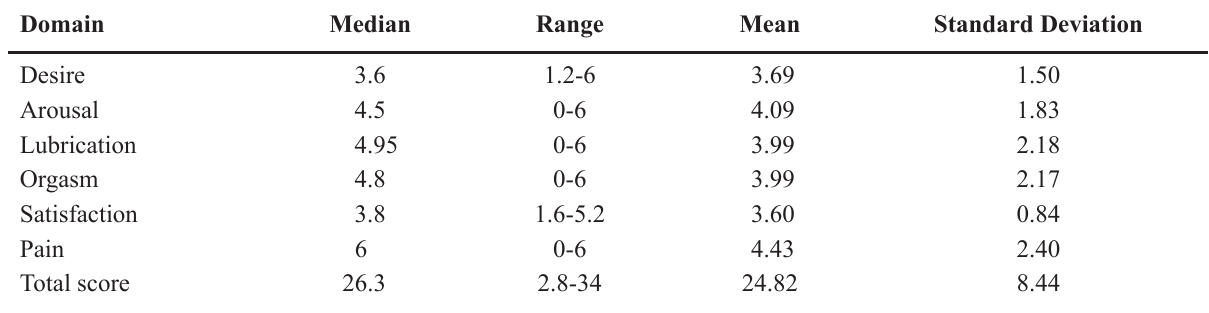
Table 2 – Female partner FSFI domain